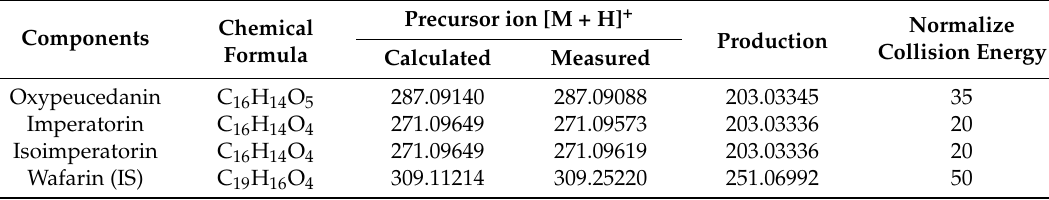
Table 6. The information of PRM parameters.